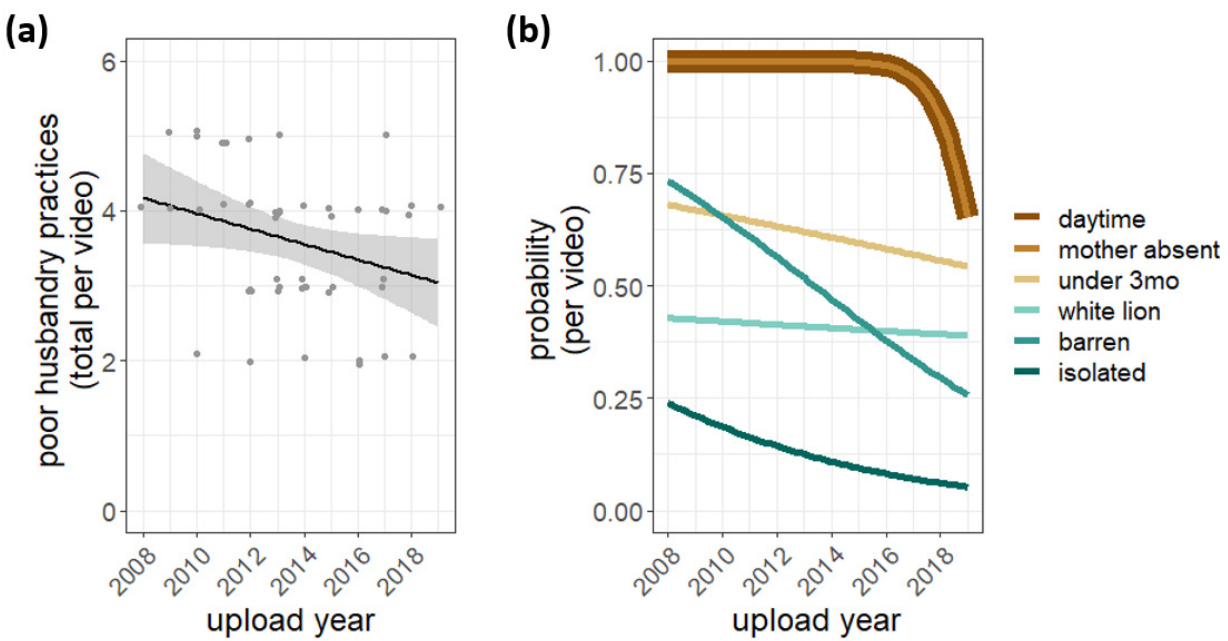
Figure 3. Poor husbandry practices over time. ( a ) The dots are the total number of poor husbandry practices in each video (6 max). The black line and grey band are the best-fit linear least squares line and its associated standard error ( p < 0.04). ( b ) Each line represents the logistic regression model for the probability of observing a particular poor husbandry practice in a video for each year. Note: Double line at the top of Figure 3b represents the curve for “daytime” and “mother absent”, which followed the identical trajectory. All poor husbandry practices tended to decrease over time, but due to low power, testing for statistical significance of each poor husbandry practice in isolation was not possible.